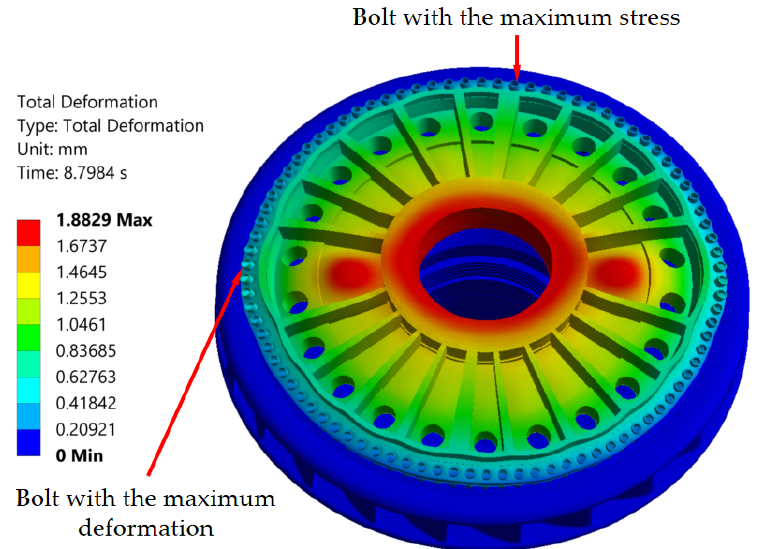
Figure 24. Stress and deformation distribution in the cross-section of different bolts.